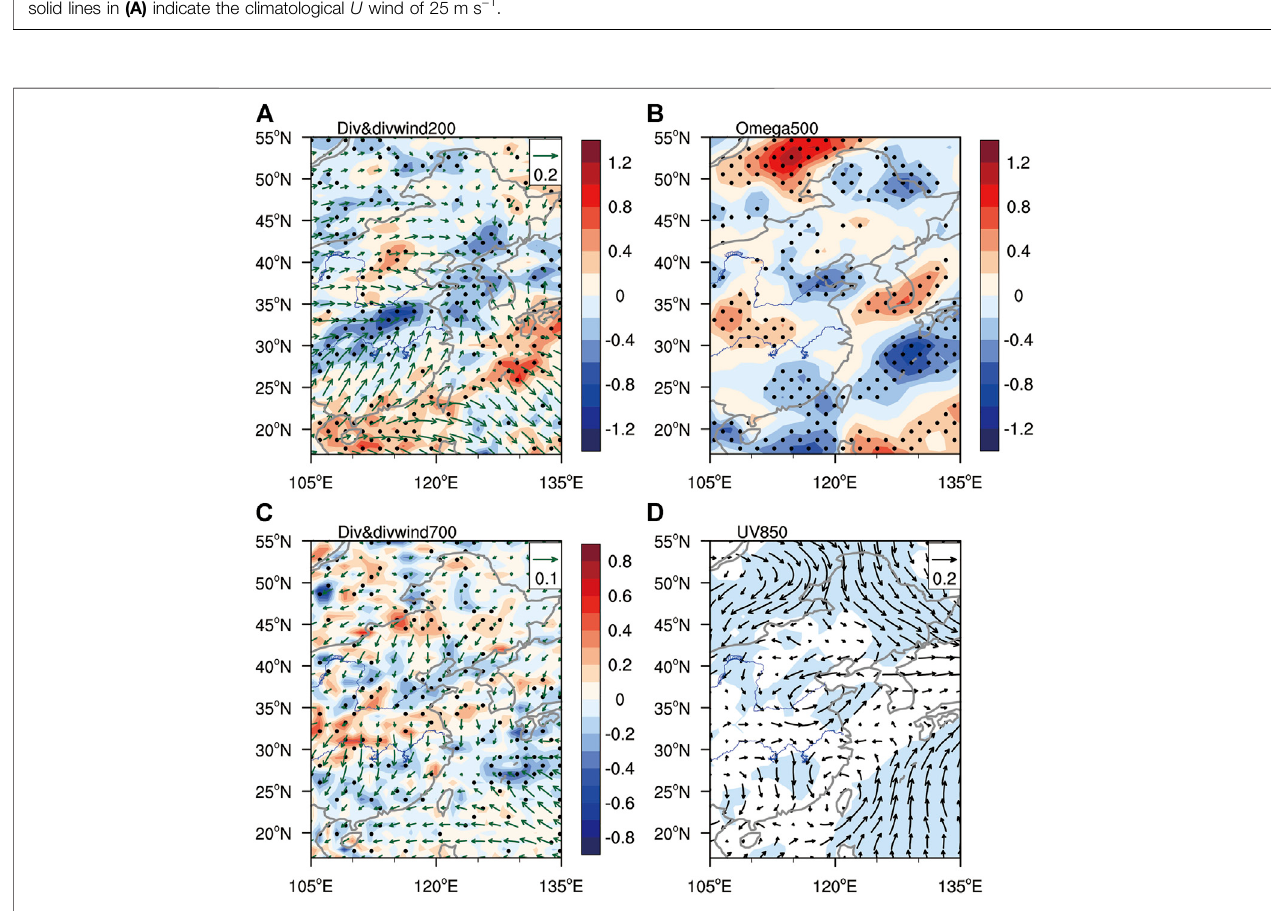
FIGURE 10 | Regression maps of the 9-years low-pass fi ltered circulations in summer (JJA) with regard to the SSDI. (A) 200-hPa divergence (shading; 10 – 6 s − 1 ) and divergent wind (vector; m s − 1 ), (B) 500-hPa vertical velocity (10 – 2 Pa s − 1 ), (C) same as (A) , but for 700 hPa, and (D) 850-hPa wind (m s − 1 ). The stippled areas in (A – C) and the shaded areas in (D) denote the regression coef fi cients that are statistically signi fi cant at the 95% con fi dence level.